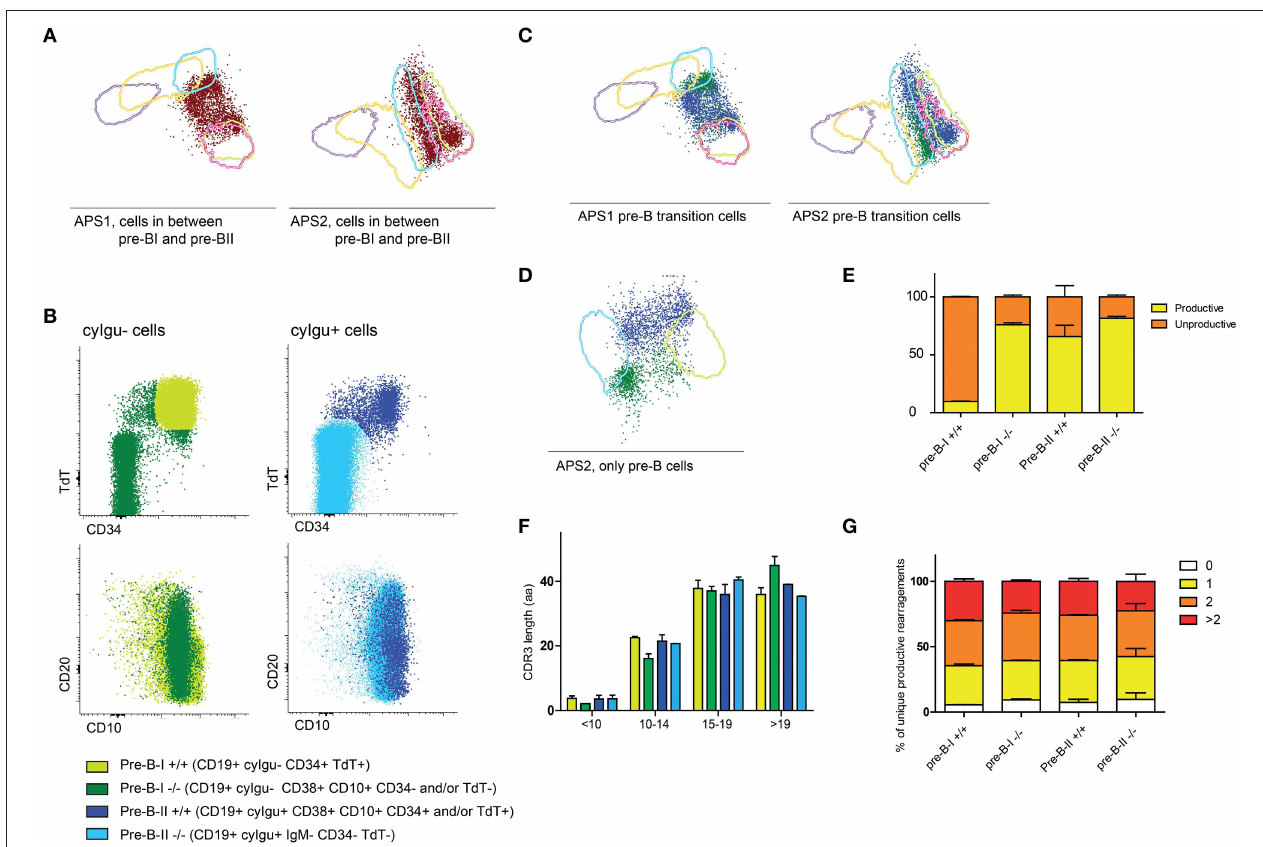
FIGURE 5 | Further dissection of the BCP compartment. (A) APS views indicating the cells that are outside the 2SD lines of the pre-B-I and pre-B-II populations of healthy controls. (B) Expression of CD34, TdT, CD10, and CD20 within cyIg µ - (in green) and cyIg µ + cells. All cells here are CD19 + CD10 + CD38 + indicating that they are bone marrow derived B cells. (C) APS views indicating the cells that are outside the 2SD lines of the pre-BI and pre-BII populations of healthy controls, color coded as in B. (D) APS view supervised on pre-BI and pre-BII cells, separating the transitioning pre-B cells further. (E) Distribution of in-frame and out-of-frame DNA-rearrangements in sorted pre-B subpopulations. (F) CDR3 length of productive rearrangements of the four sorted pre-B-I and pre-B-II populations. (G) The proportion of CDR3 regions with ≥ 3, 2, 1, or 0 positive